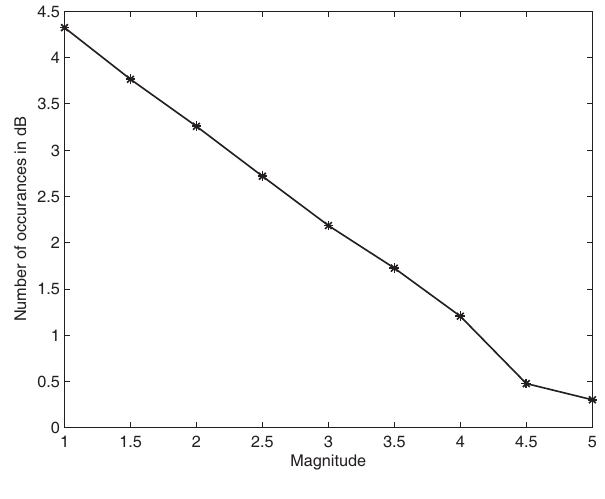
Fig. 1. Gutenberg–Richter relationship for synthetic Fig. 1. Gutenberg-Richter relationship for synthetic catalog